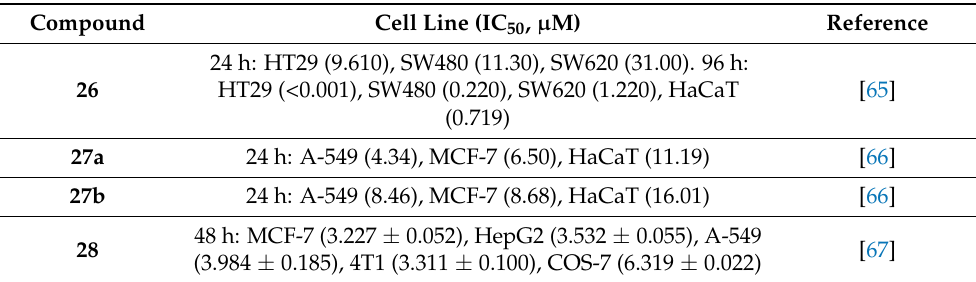
Figure 28. Structure of the [Cu 2 (L4)(phen)](ClO 4 ) complex. IC 50 values for the polynuclear complexes here reported are summarized in Table 6. Table 6. IC 50 values of compounds 26–28b